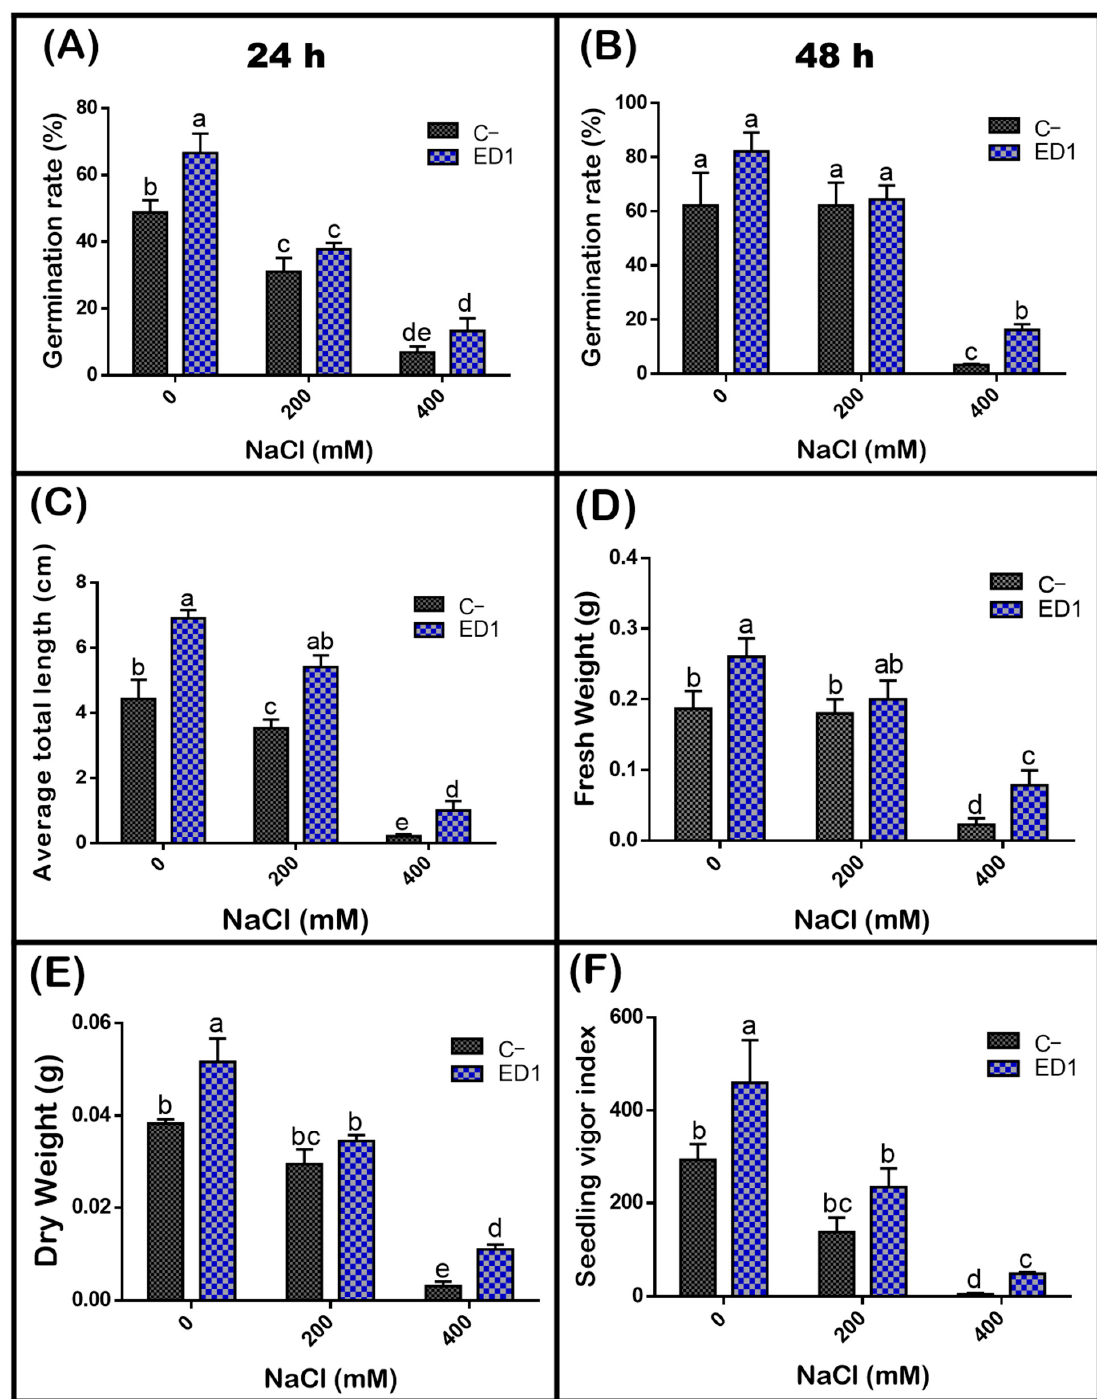
Figure 8. Effect of the S. rubidaea ED1 strain on quinoa seed germination parameters under different salinity treatments (0, 200, and 400 mM NaCl) after 48 h of incubation at 25 °C. C − (negative control; Seeds inoculated with phosphate-buffered saline (PBS)), ED1 (Seed treated with the ED1 strain): ( A ) Germination rate after 24 h of incubation, ( B ) germination rate after 48 h of incubation, ( C ) average of total length of seedlings, ( D ) average of fresh weight of seedlings, ( E ) average of dry weight of seedlings, and ( F ) seedling vigor index. The values represent means of three replicates ( n = 3) ± SD. The different letters in superscript (a–e) indicate the statistically significant difference at 95% between treatments.